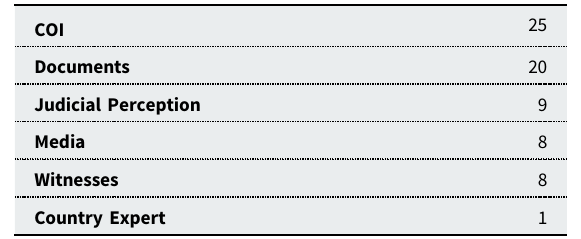
Table 3. External Consistency in More